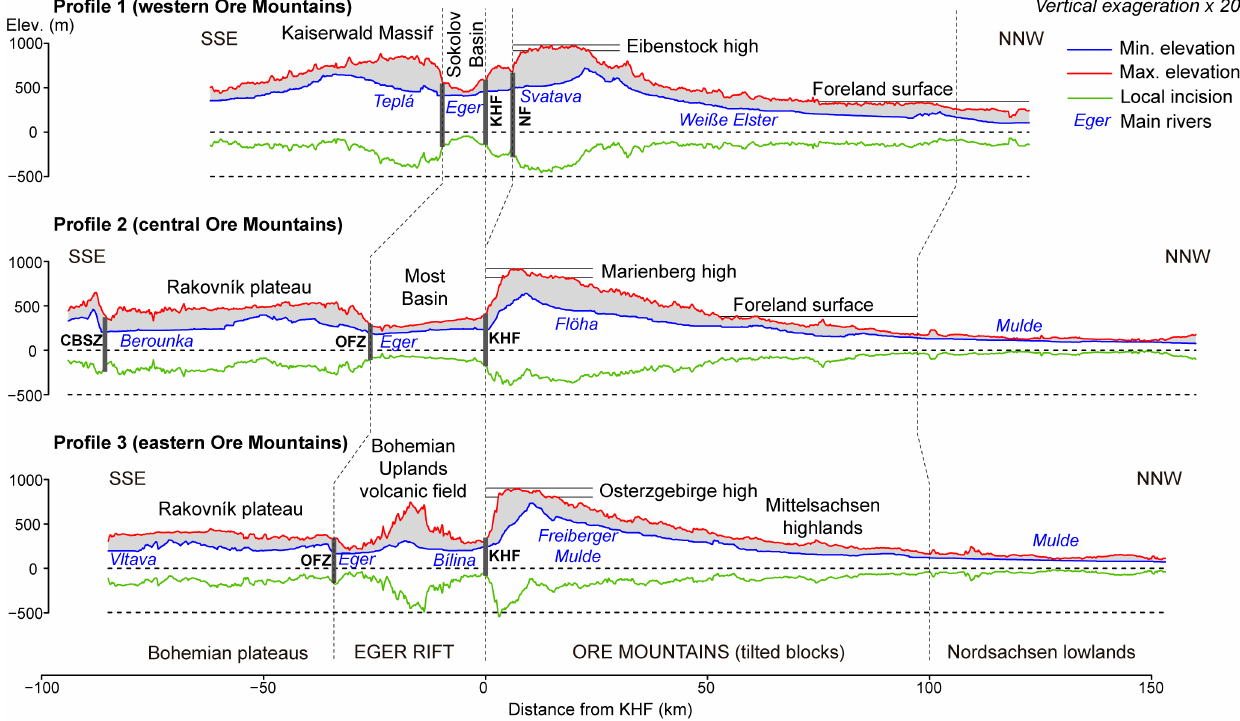
Figure 7. Topographic swath profiles across the Eger Rift and Ore Mountains. See the locations in Figure 3. Swath widths are 15 km. CBSZ, Central Bohemian Shear Zone,